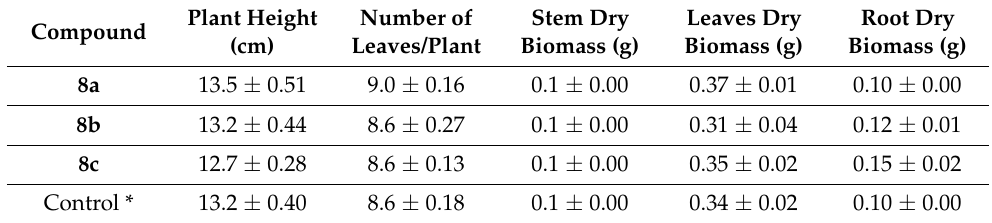
Table 5. Means ± standard error of growth and biomass accumulation in habanero pepper plants treated with foliar applications of compounds 8a – c . The applications were conducted 10 and 17 days after transplanting, and the evaluations were performed 25 days after